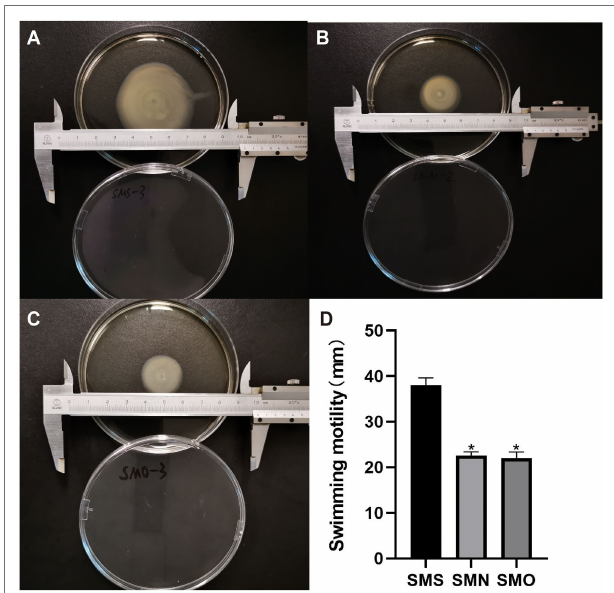
FIGURE 5 | Effect of SMG on mobility of S. maltophilia . For the swimming motility, three groups were inoculated on a surface of 0.1% (w/v) Bacto agar plates. Swimming haloes were gauged after 48 h of incubation at 37 ° C. Zone diameters (means ± SD; n = 3) are listed for each group. (A) SMS (37.96 ± 1.34 mm), (B) SMN (22.56 ± 0.68 mm), and (C) SMO (21.96 ± 1.13 mm). (D) Asterisks (*) indicate statistically significant change ( p < 0.05) compared to that of SMS group. * p <